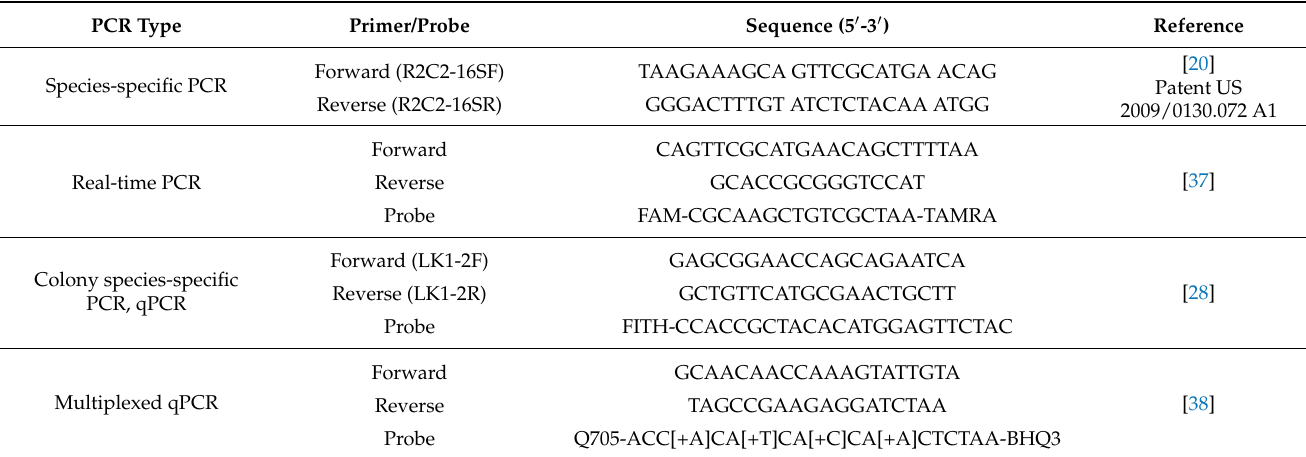
Table 1. Sequences of the species-specific primers and probes targeting Lactobacillus kefiranofaciens as applied in chronologi- cal